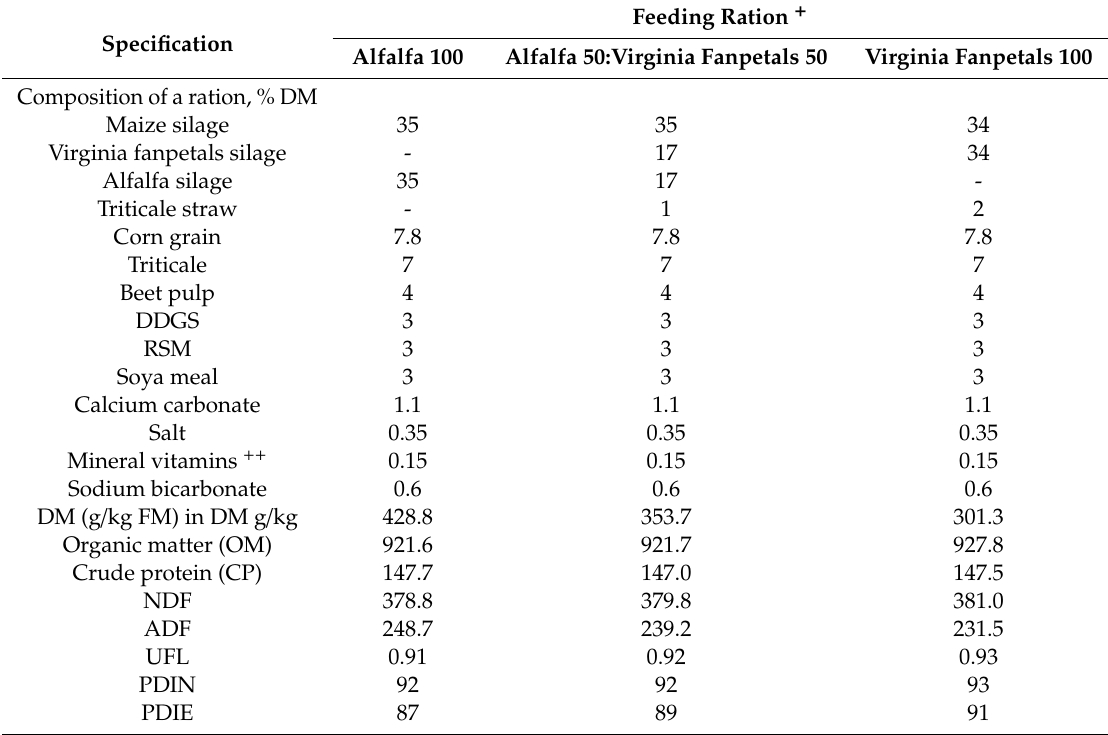
Table 1. Ingredients and chemical composition of experimental diets fed to dairy cows ( n = 3 sample